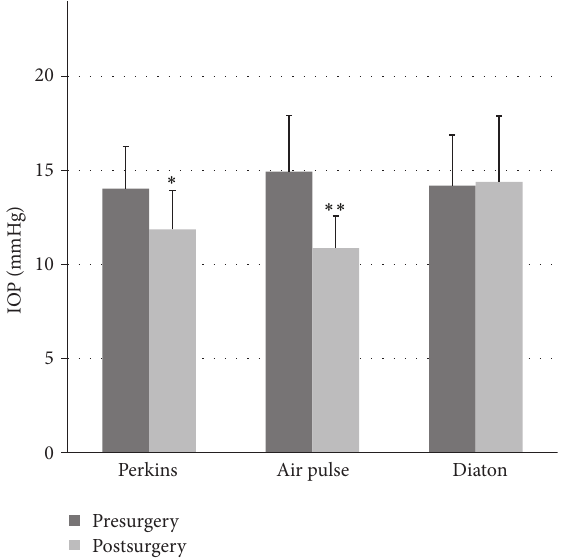
Figure 1: Comparison of the pre- and postsurgery IOP for the Perkins, noncontact, and transpalpebral tonometries ( ∗ 𝑝 < 0.05 Diaton versus Perkins; ∗∗ 𝑝 < 0.05 Diaton versus air pulse tonometry; Student’s t- test for independent